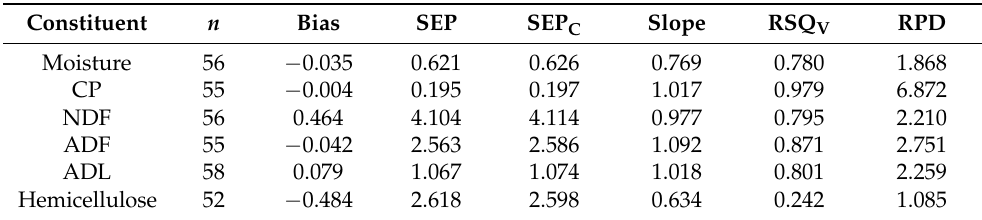
Table 7. Monitoring statistics for the NIR spectroscopic prediction equation for six constituents of straw materials.